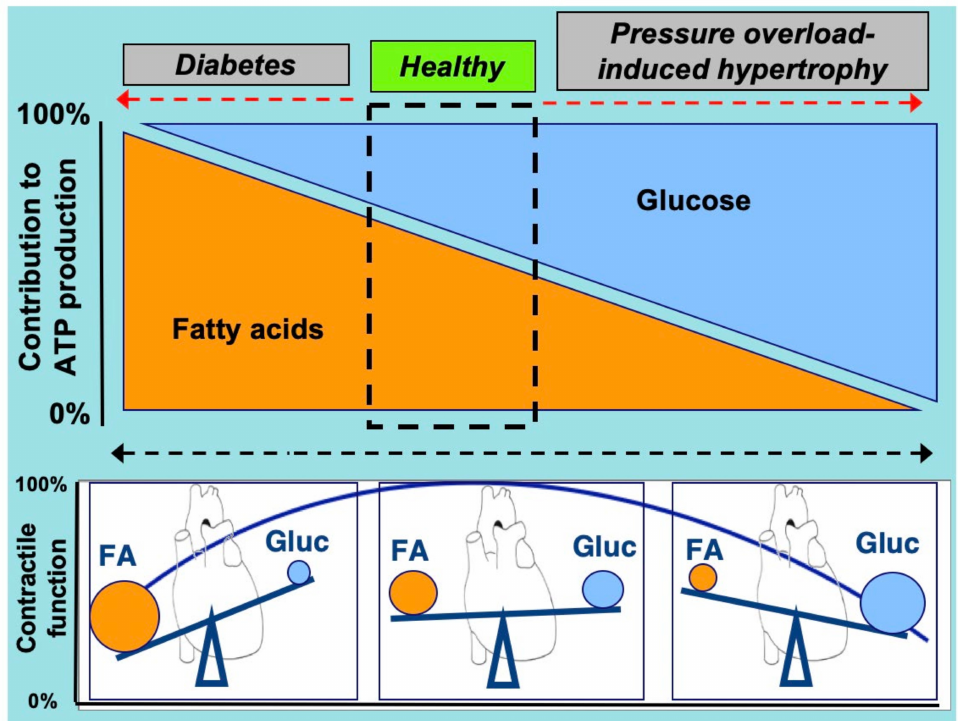
Figure 1. Schematic presentation of the relation between cardiac contractile function and the relative contributions of (long-chain) fatty acids and glucose to overall myocardial ATP production. Not shown are minor contributions from other substrates, such as lactate, ketone bodies, and amino